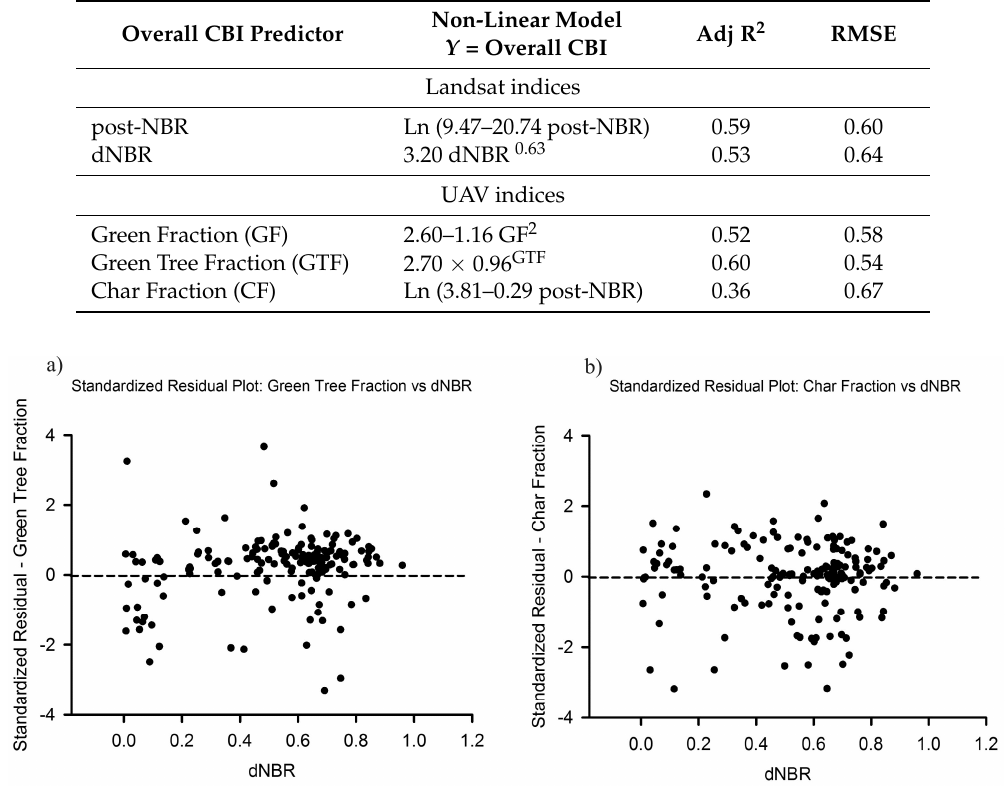
Table 4. Best fit non-linear models for predicting the overall CBI using the Landsat and UAV severity indices.